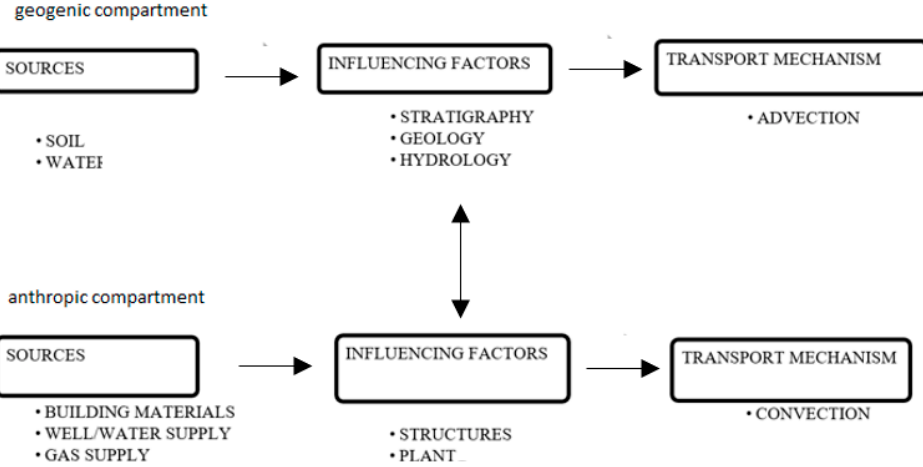
Figure 4. Environmental-occupational determinant: identifying risk and categorizing sources.